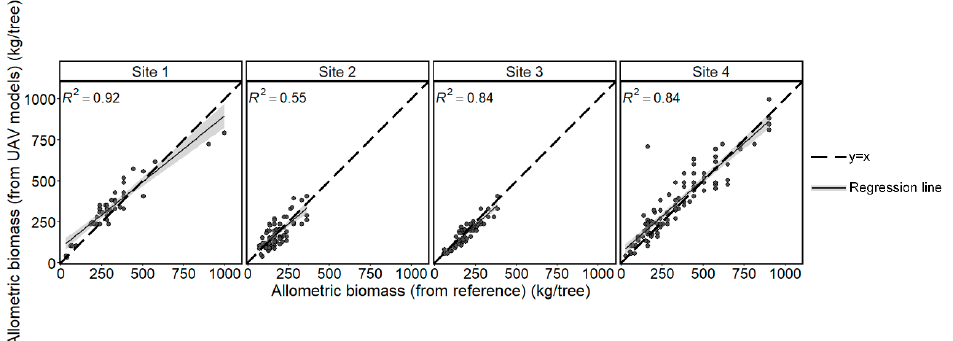
Figure A9. Site-specific AGB values obtained from allometric equations on variables measured by UAV (vertical axis) and reference values (horizontal axis) in coppice stands in Zone 3.